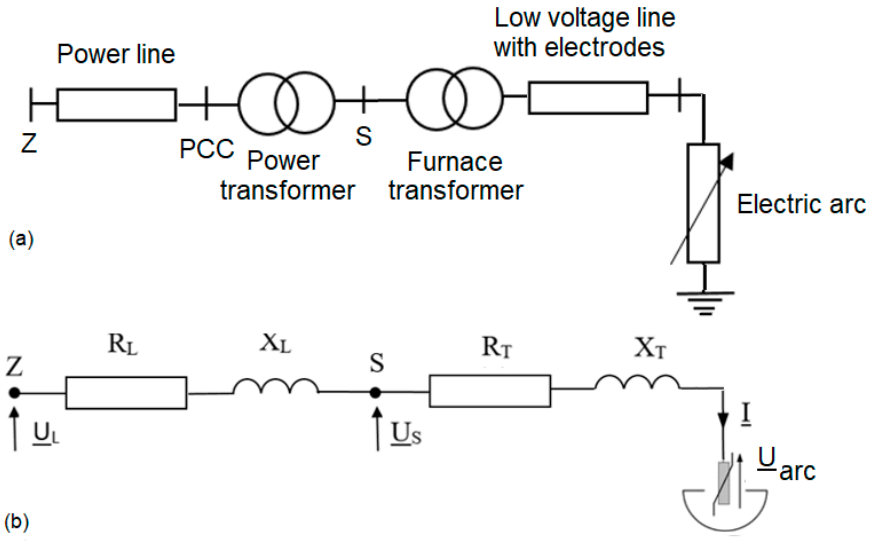
Figure 5. Arc furnace power supply ( a ) and its single-phase equivalent circuit ( b ) Z L : the power line impedance; Z T : the high-current path impedance; S cc : short circuit power of the network in PCC; S ctr : power in three-phase short circuit electrodes with a charge; U arc : the arc voltage. The supply voltage (source) U L was adopted as a sinusoidal reference voltage of U L = 100%,